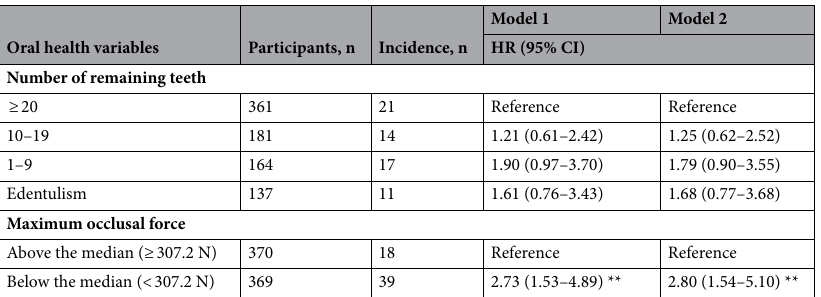
Above the median (≥ 307.2